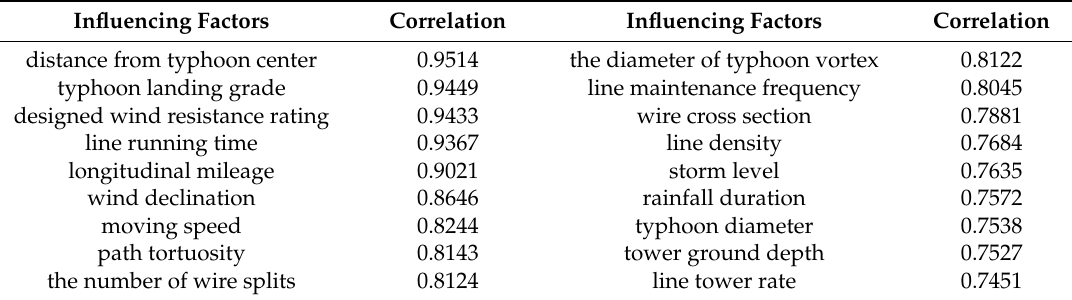
Table 1. Correlation analysis of 18 influencing factors.